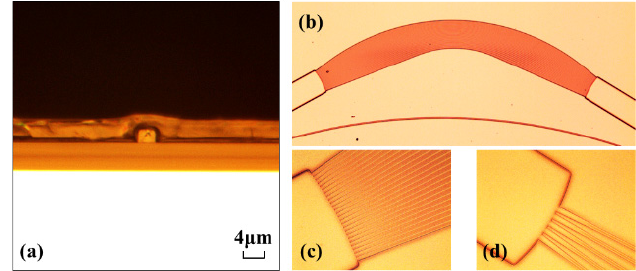
Figure 4. The fabrication process of the AWG. Figure 5. The micrographs of the fabricated AWG: ( a ) the crossing diagram, ( b ) the overall structure diagram and ( c,d ) partial enlarged diagram of the fabricated AWG.